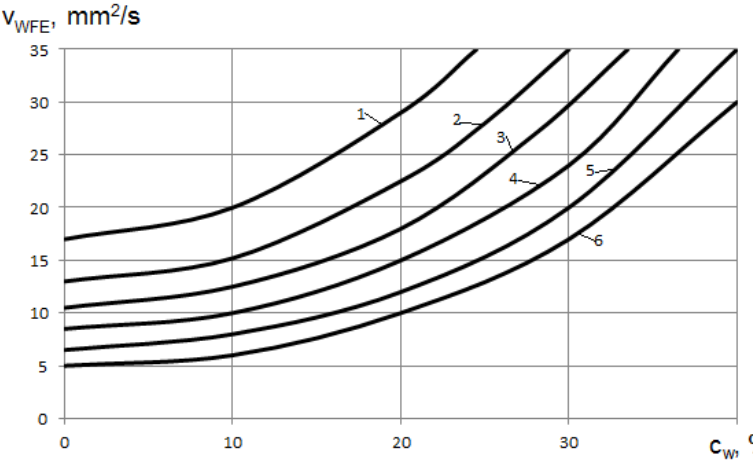
Figure 2. Influence of water concentration in water–fuel emulsion on its viscosity at different temperatures. 1: t WFE = 40 °C, 2: t WFE = 50 °C, 3: t WFE = 60 °C, 4: t WFE = 70 °C, 5: t WFE = 80 °C, 6: t WFE = 100 °C.